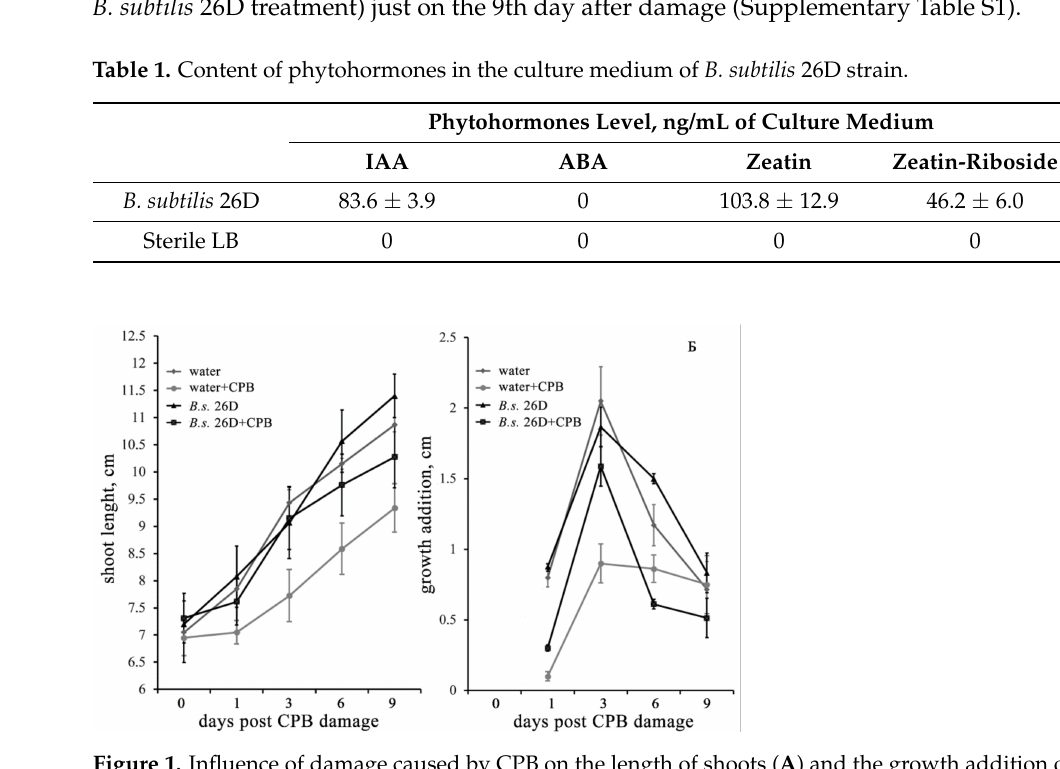
Figure 1. Influence of damage caused by CPB on the length of shoots ( A ) and the growth addition of shoots ( B ) of potato plants treated with water or suspension of B. subtilis 26D. The values are means, and the vertical bars represent standard errors. Data analyzed using two-way ANOVA with Tukey’s post hoc test. Asterisks indicate means statistically different from the control at p ≤ 0.05. CPB—plants damaged by Colorado potato